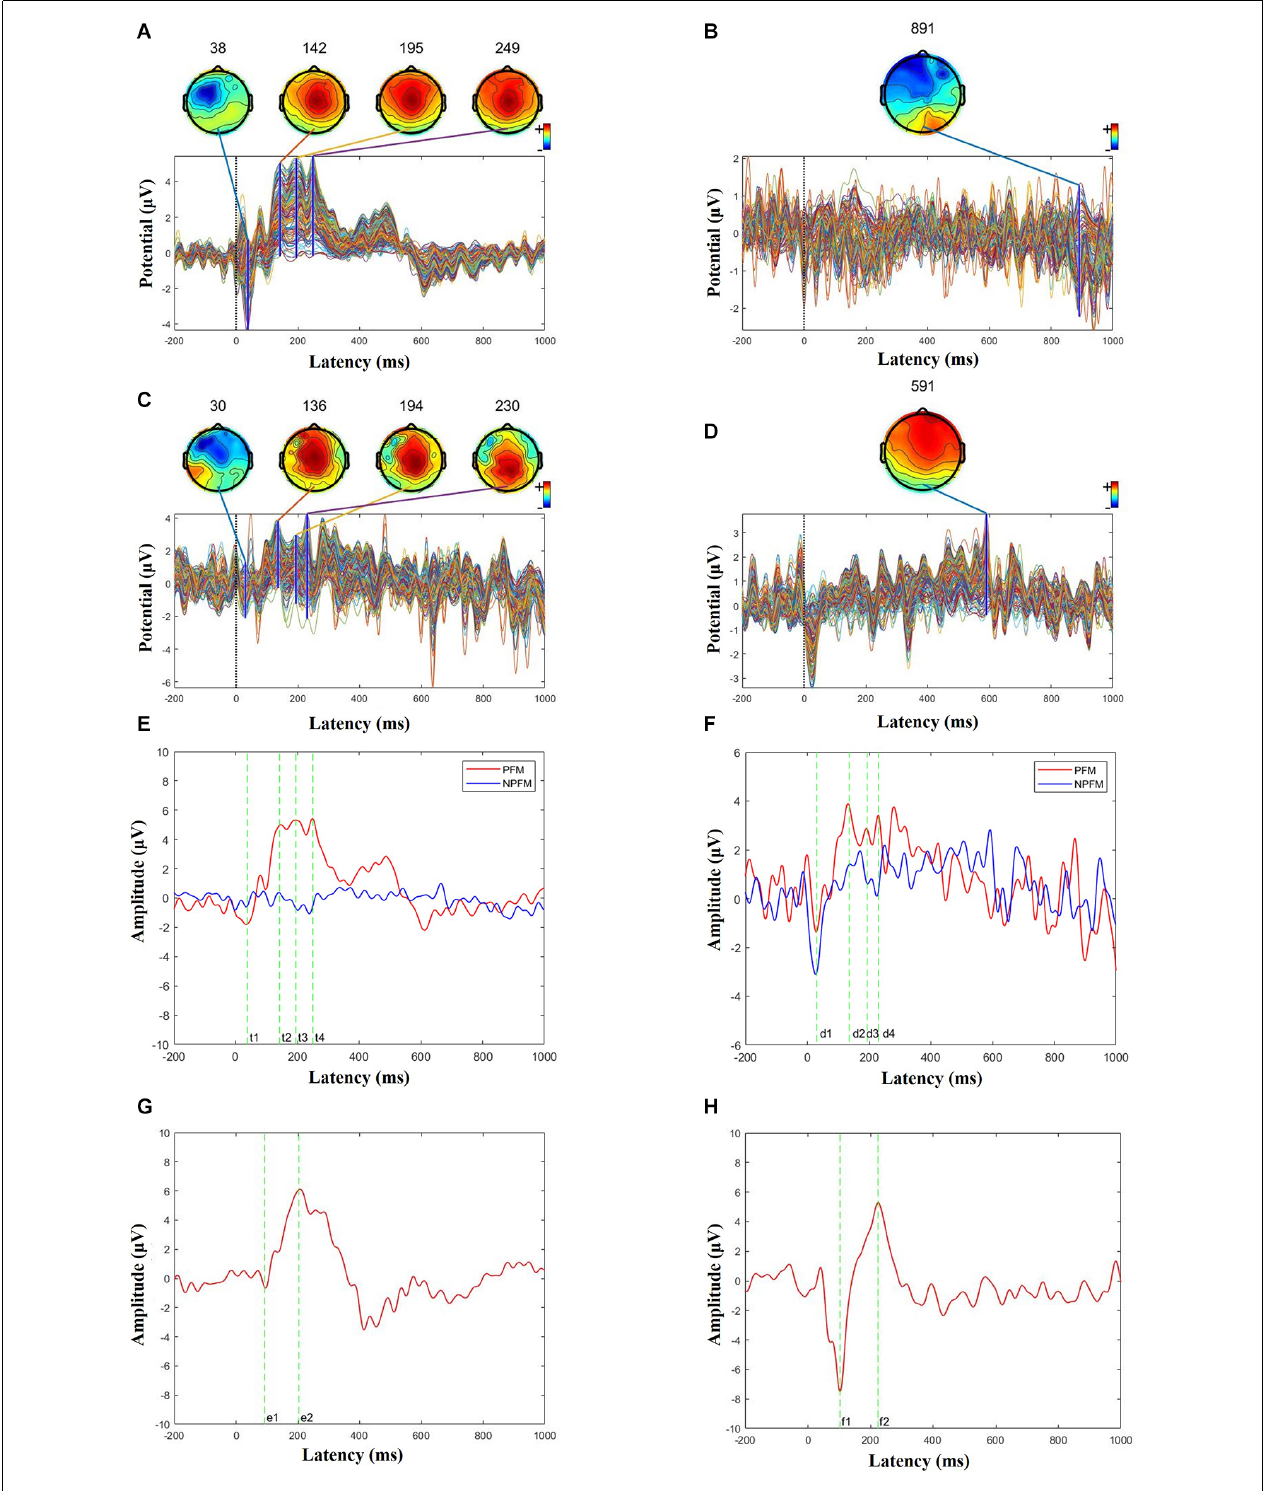
FIGURE 4 | Butterfly and ERP maps. (A) PFM butterfly map of subject 1. (B) NPFM butterfly map of subject 1. (C) PFM butterfly map of subject 2. (D) NPFM butterfly map of subject 2. (E) Superimposed PFM and NPFMERP figure of subject 1 ( t 1 = 38 ms, t 2 = 142 ms, t 3 = 195 ms, t 4 = 249 ms). (F) Superimposed PFM and NPFM ERP figure of subject 2 ( d 1 = 30 ms, d 2 = 136 ms, d 3 = 194 ms, d 4 = 230 ms). (G) Superimposed healthy finger ERP figure of subject 1 ( e 1 = 93 ms, e 2 = 204 ms). (H) Superimposed healthy finger ERP figure of subject 2 ( f 1 = 103 ms, f 2 = 224 ms).